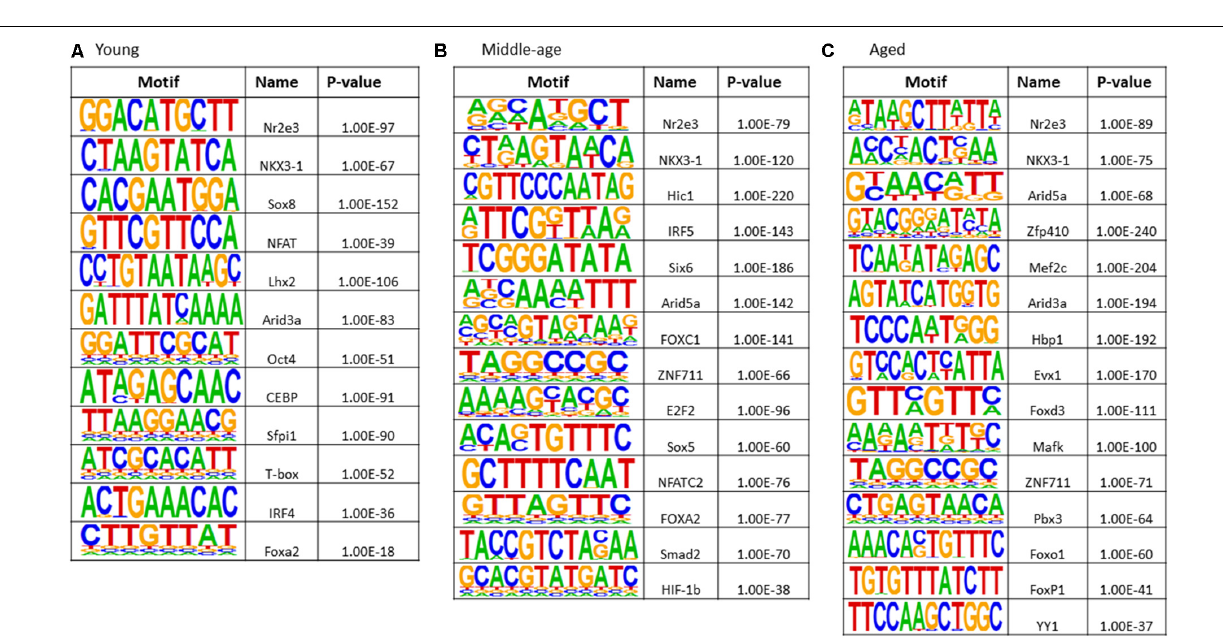
Frontiers in Aging Neuroscience |